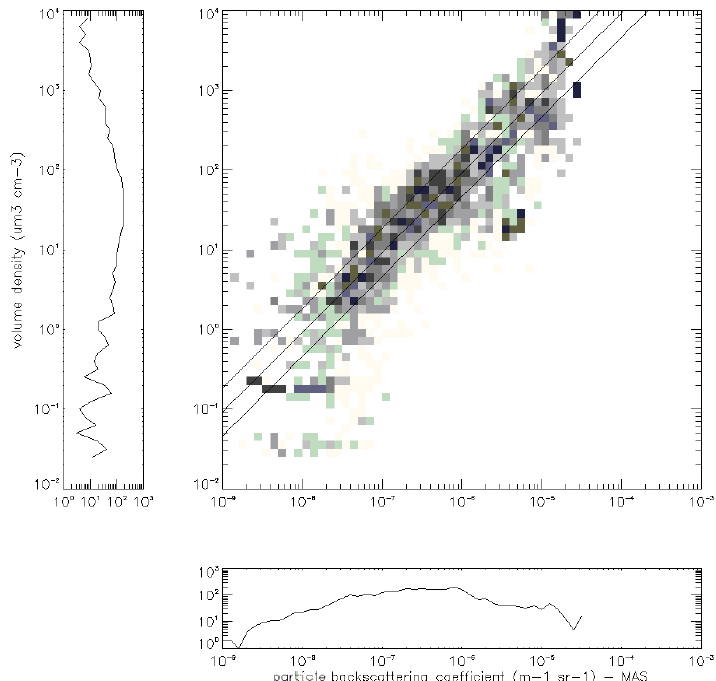
Fig. 8. Observation frequency histogram for β measured by the backscattersonde (horizontal, below) and for the particle volume density V (vertical, on the left). The central panel shows, in arbitrary units color coded in gray scale, the joint probability density distribution for the two quantities. A linear fit with the parameters reported in Table 2, together with a region wheere the mismatch is below a factor 2, is also